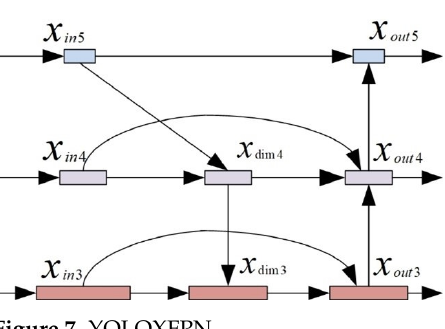
Figure 7. YOLOXFPN.